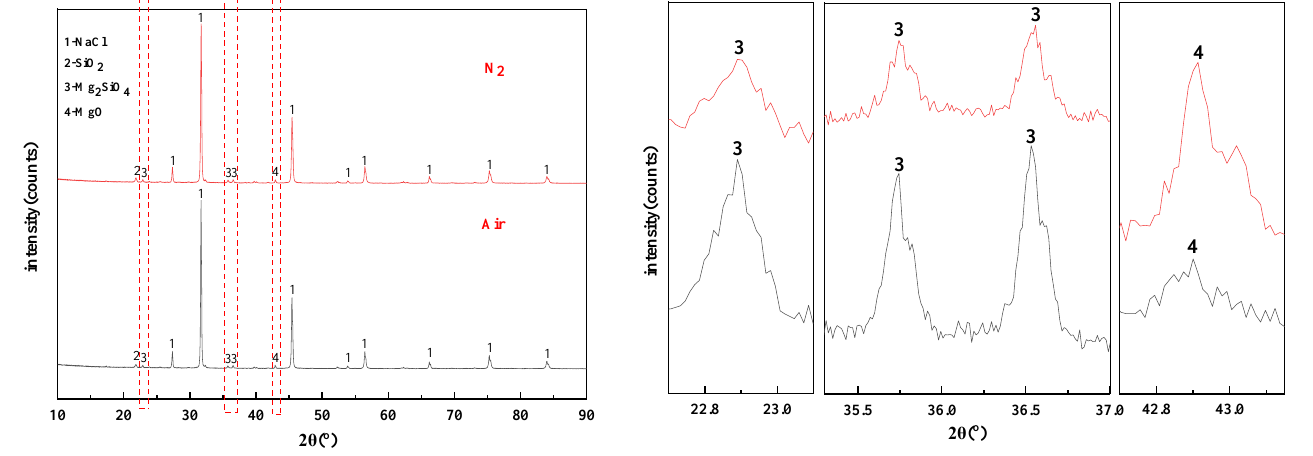
Figure 15. XRD of filter residues obtained with different atmosphere. The effects of different phase transition atmospheres on the Mg content in the filtrate were investigated under the conditions of additive dosages MgCl 2 :Na 2 SiO 3 = 1:0.5, 1:1, and 1:1.5, as shown in Figure 16. When N 2 was the phase transition atmosphere, the Mg content in the filtrate was significantly lower than that in the air atmosphere. This indicates that the N 2 condition can effectively reduce the content of Mg in the filtrate. When the additive dosage was 1:1.5, the content of impurity Mg in the filtrate was similar and lower in both atmosphere conditions.